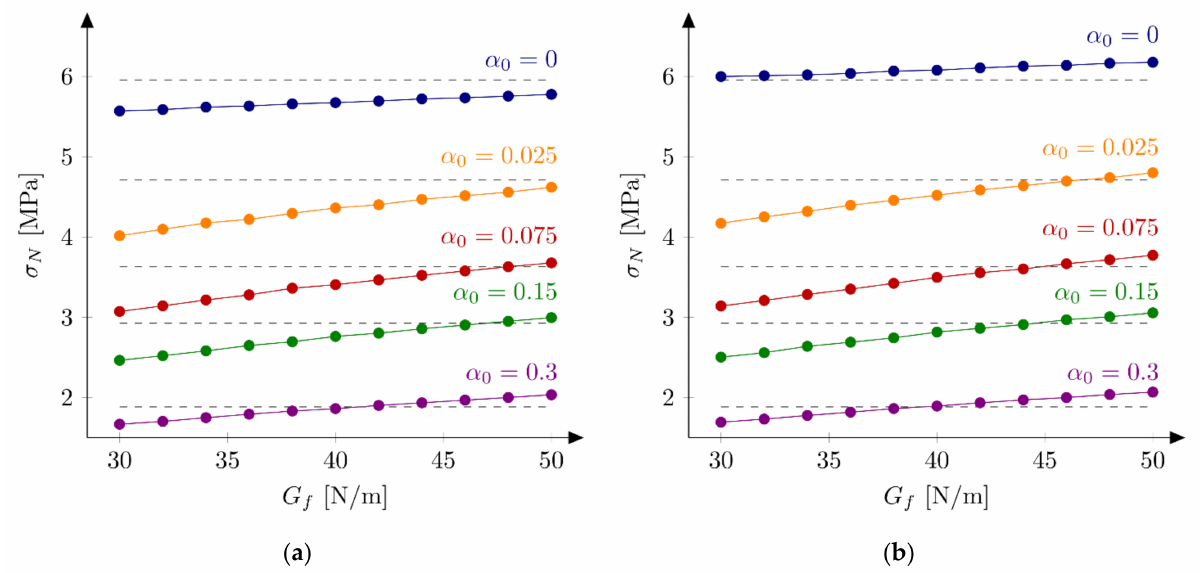
Figure 5. Nominal strengths σ FEM for the huge beam, different initial fracture energies and the tensile N strength: ( a ) f t =4.8 MPa; ( b ) f t = 5.2